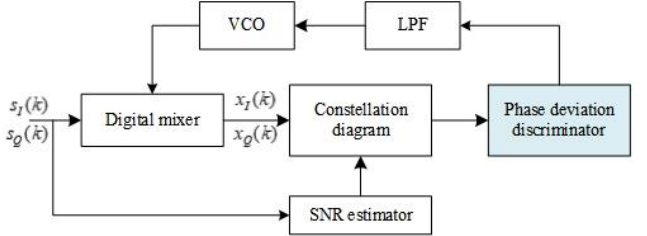
Figure 1. Block diagram of carrier synchronization based on feedback loop.